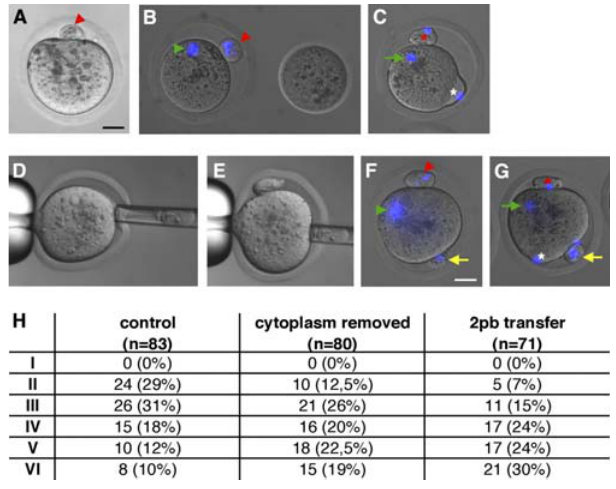
Figure 4. Experimental Enlargement of the PVS in the Non-pb Half Increases the Probability of Fertilization in This Area (A–C) Removal of cytoplasm at MII stage and fertilization in non-pb half of a manipulated embryo. (A) MII oocyte. (B) Manipulated oocyte (left) following removal of half of its original volume (right). (C) Fertilized zygote. (D–G) 2pb transplantation and fertilization in non-pb half of manipulated embryo. (D) 2pb removal from donor zygote. (E) 2pb transfer to another oocyte. (F) MII oocyte with additional 2pb and PVS. (G) Fertilized zygote. (H) Classification of embryos according to their site of fertilization with respect to the 2pb under control and manipulated conditions. Zones I–VI are defined as in Figure 1. Red arrowheads indicate the 1pb, red asterisks indicate the 2pb, white asterisks indicate the fertilization cone, green arrowheads indicate MII chromosomes, green arrows indicate condensed female chromosomes, and yellow arrows indicate the transplanted 2pb. Scale bars in (A) and (F) represent 20 l